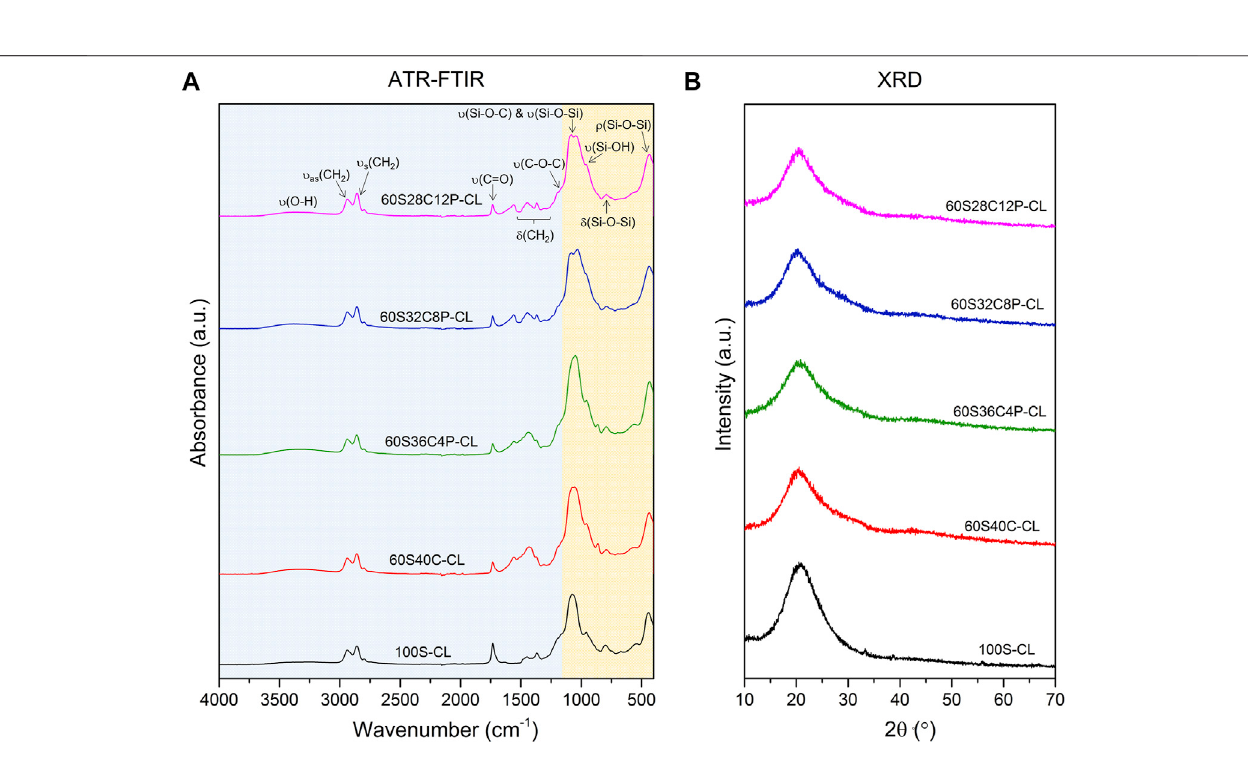
FIGURE 2 | ATR-FTIR spectra (A) and XRD patterns (B) of the SiO 2 -CaO-P 2 O 5 /PTHF/PCL-diCOOH hybrid compositions: in (A) the region highlighted in orange (~450 – 1,200 cm − 1 ) represents the contribution of the inorganic component, while the region highlighted in blue (~1,200 – 4,000 cm − 1 ) represents the contribution of the organic components (i.e., PTHF and